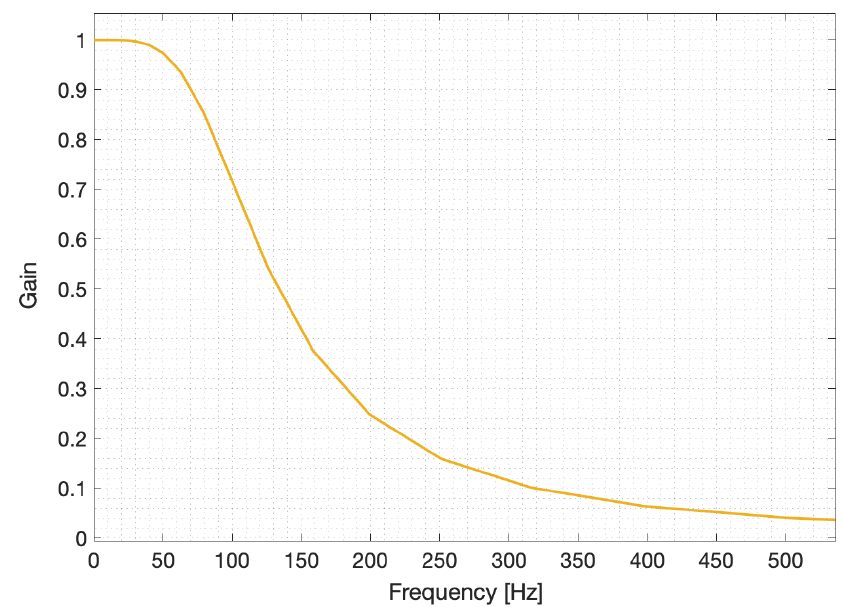
Figure 8. Magnitude response for the low-pass filter. The plot shows the filter’s gain for different sinusoidal inputs frequencies. The filter is configured to reject frequencies higher than f c = 100